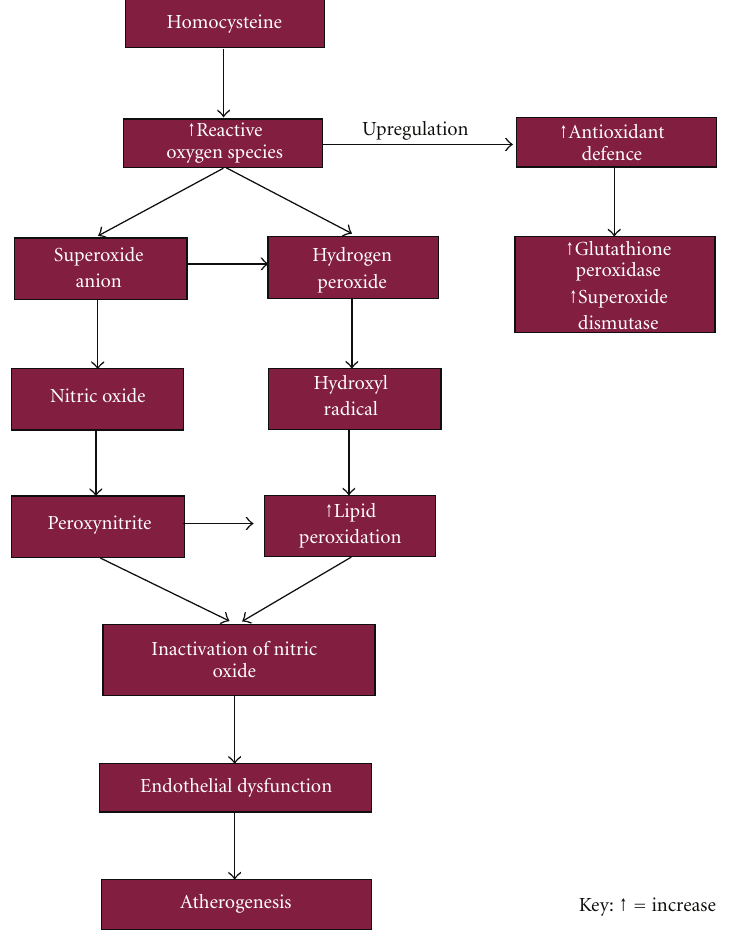
Figure 1: Proposed mechanism of homocysteine-induced endothelial dysfunction and atherogenesis